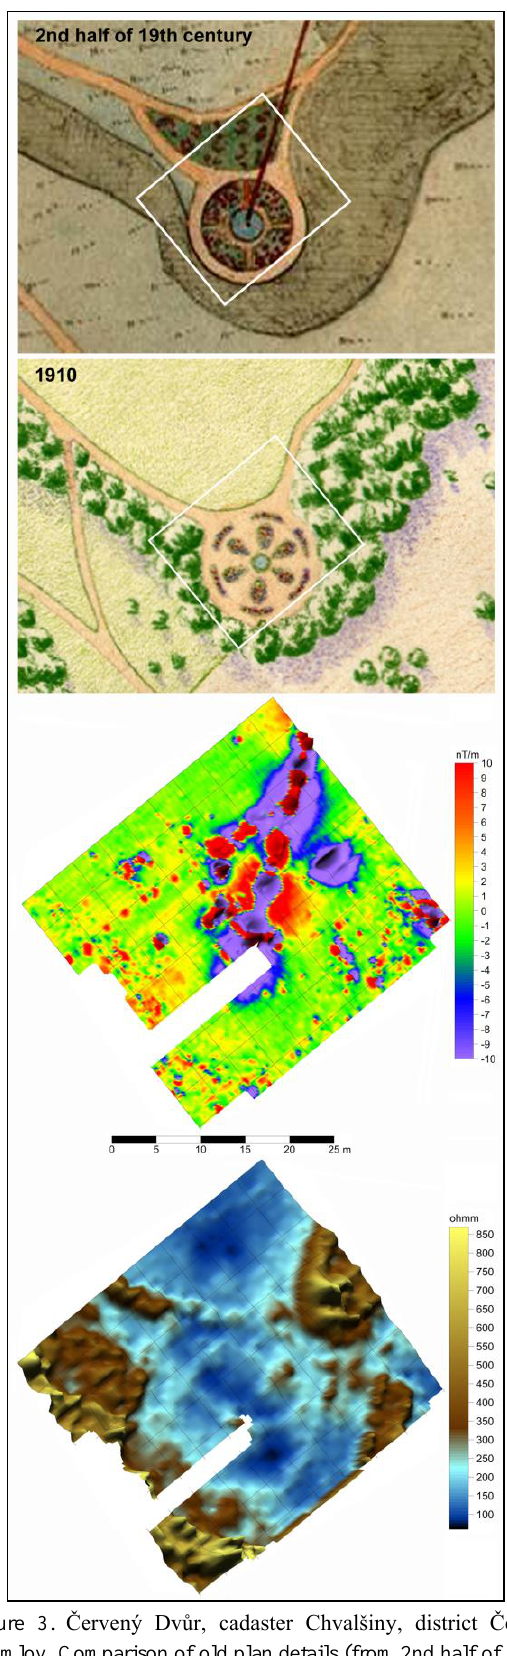
Figure 3. Červený Dvůr, cadaster Chvalšiny, district Český Krumlov. Comparison of old plan details (from 2nd half of 19th century and 1911) and results of magnetometric and geoelectric restivity measurements of area of extinct rose garden (surveyed area: approx. 0.2 ha; geophysical survey: Křivánek